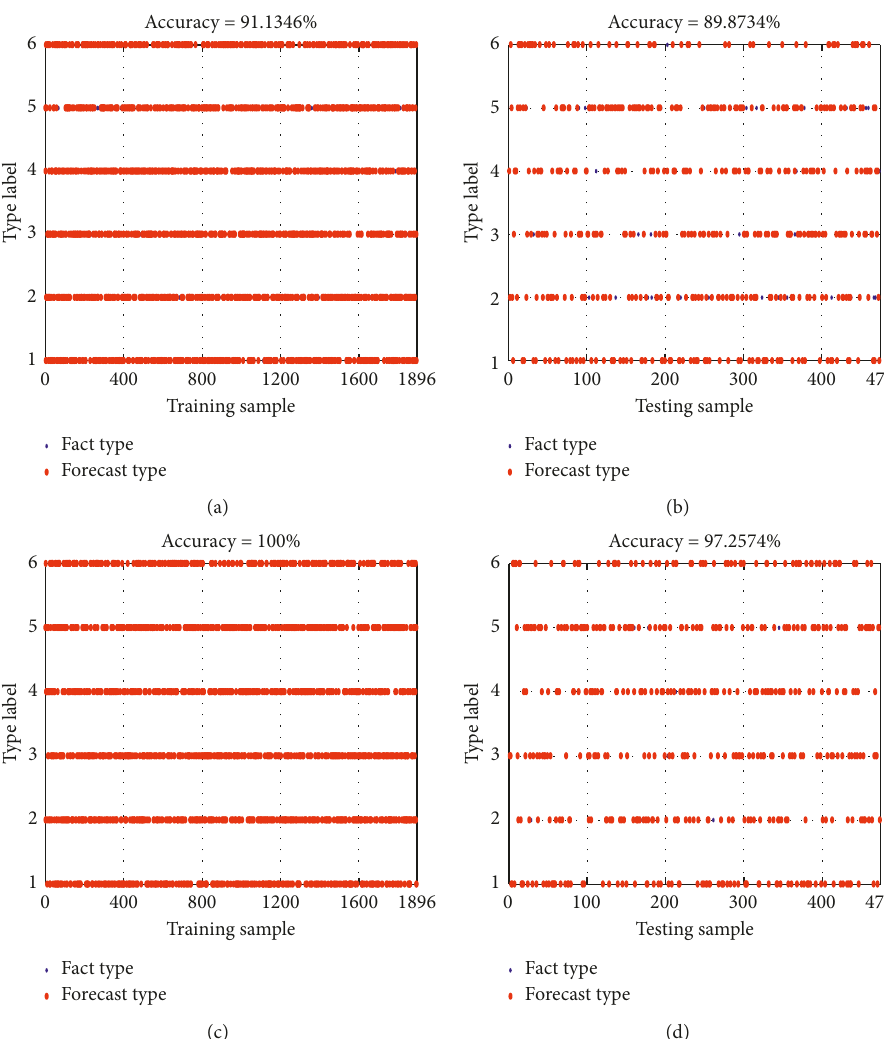
Figure 7: The diagnostic accuracy of the KELM technique with (a) the training sample and (b) the test sample. The diagnostic accuracy of the CBA-KELM method with (c) the training sample and (d) the test sample.